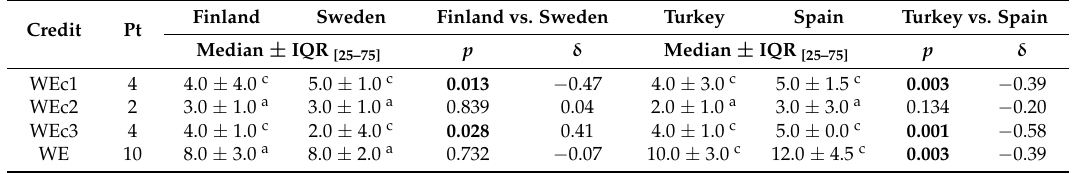
Table 4. WE achievement: Northern European countries vs. southern European